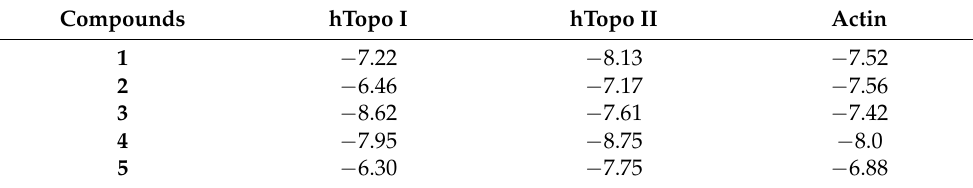
Figure 2. The three-dimensional structure of the human proteins Topoisomerase I (Panel A), Topoi- somerase II (Panel B) and Actin (Panel C) bound to compounds 3 and 4 are drawn. Proteins are schematically reported as ribbons. Ligands binding poses are described as colored sticks. Table 2. Binding free energies of carbazole derivatives against hTopo I, hTopo II and